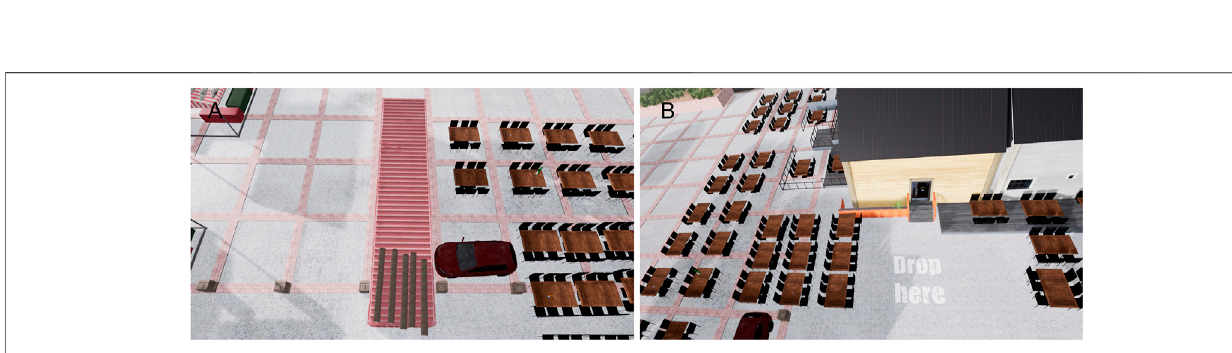
Frontiers in Virtual Reality |